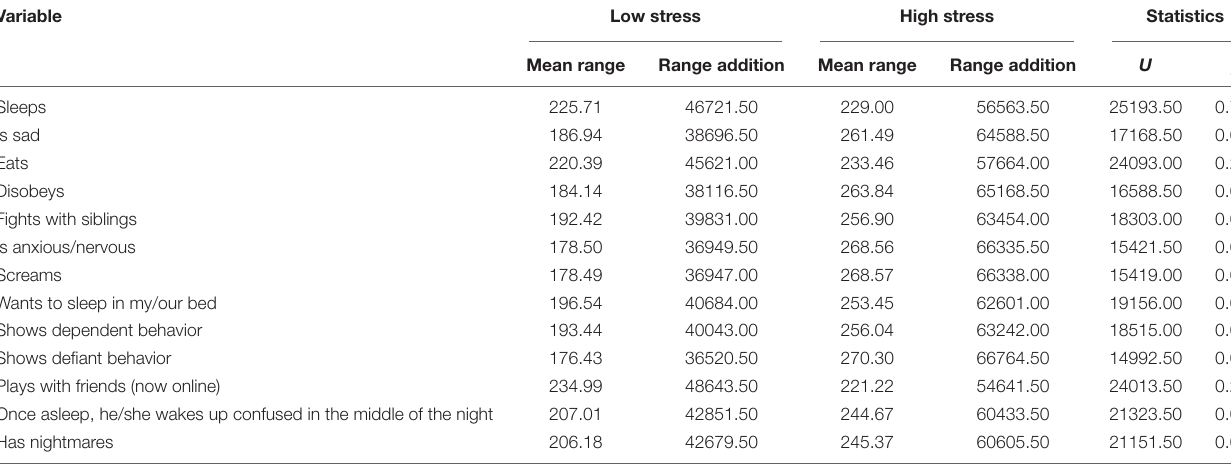
TABLE 5 | Change in children’s behavior according to the level of parenting stress.